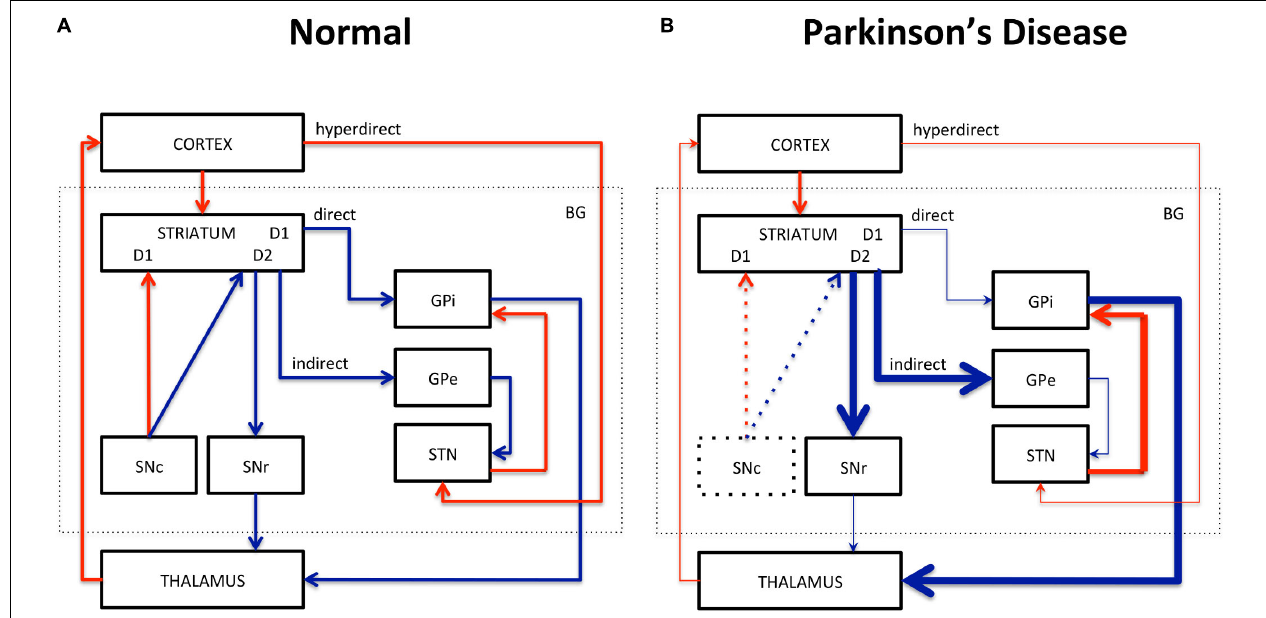
FIGURE 1 | Schematic representation of the corticobasal ganglia–thalamocortical motor pathway model. (A) Normal pathway. (B) PD pathway. Red arrows correspond to glutamatergic excitatory projection neurons. Blue arrows correspond to GABAergic inhibitory projection neurons. D 1 , D 2 : striatal receptors. SNc, subtantia nigra pars compacta; SNr, subtantia nigra pars reticulata; STN, subthalamic nucleus; GPi, globus pallidus interna; GPe, globus pallidus externa; BG, basal ganglia. The direct (STR/GPi/TH), indirect (STR/GPe/STN/GPi/TH), and hyperdirect (cortex/STN) pathways are represented. Thick lines represent increased excitation/inhibition. Thin lines represent decreased excitation/inhibition. Dotted lines represent DA neuronal loss in the